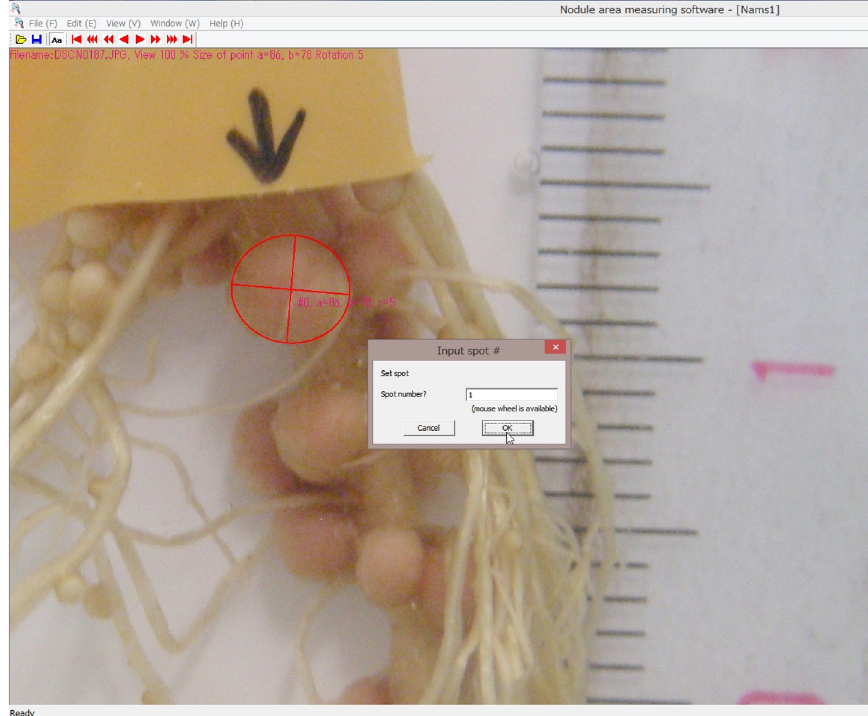
Figure 6. Software for measuring nodule area. A close-up photograph of a nodule is fit to an oval shape on the screen by moving and revolving the red oval line. The area of the nodule is calculated by the equation “ π ab”, where “a” and “b” are a half of the major and minor axes,